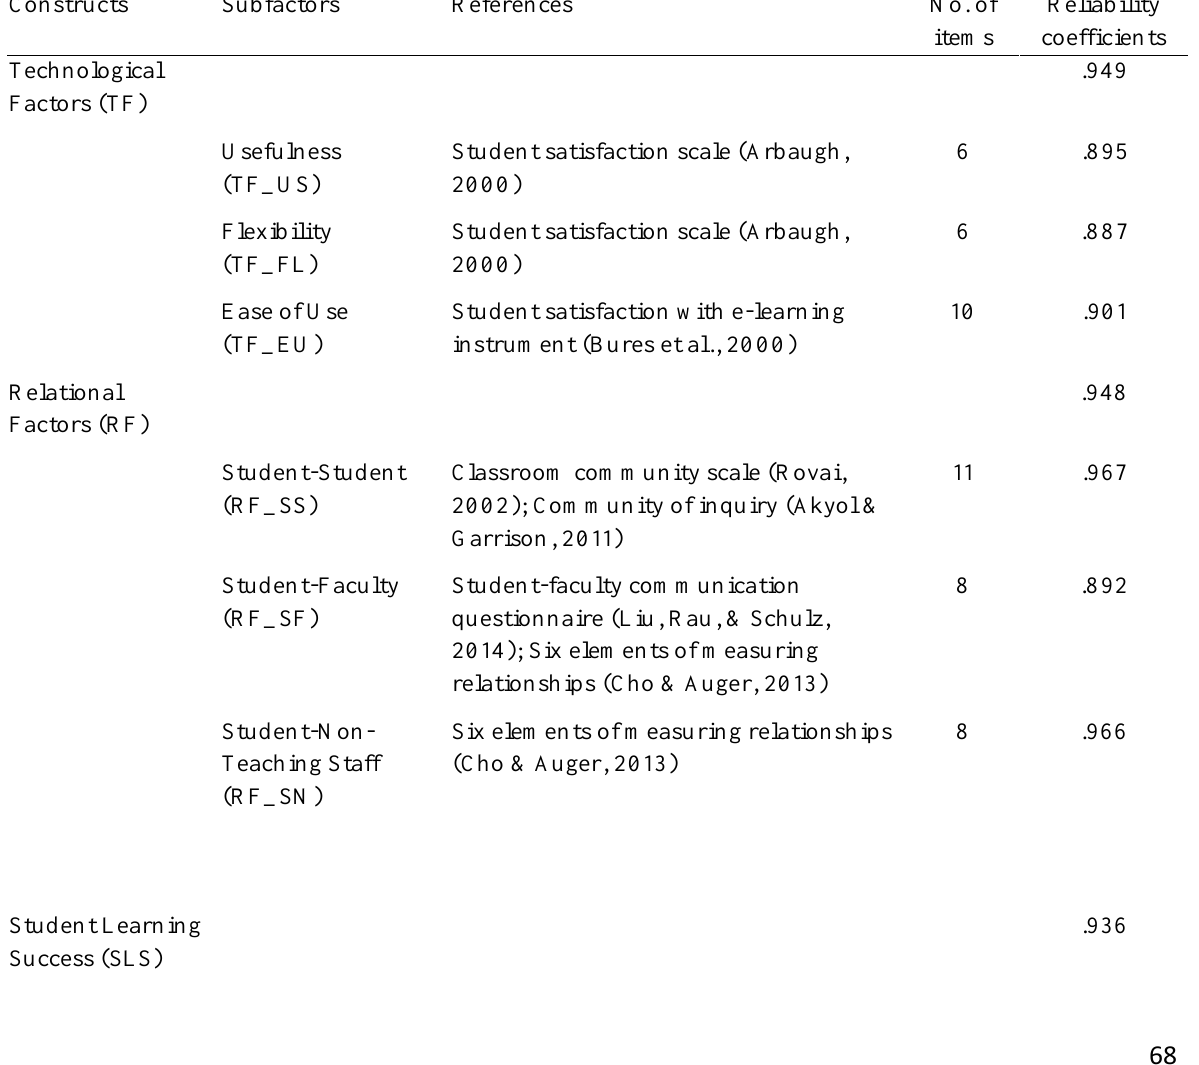
Online Learning Success Scale Information and Reliability